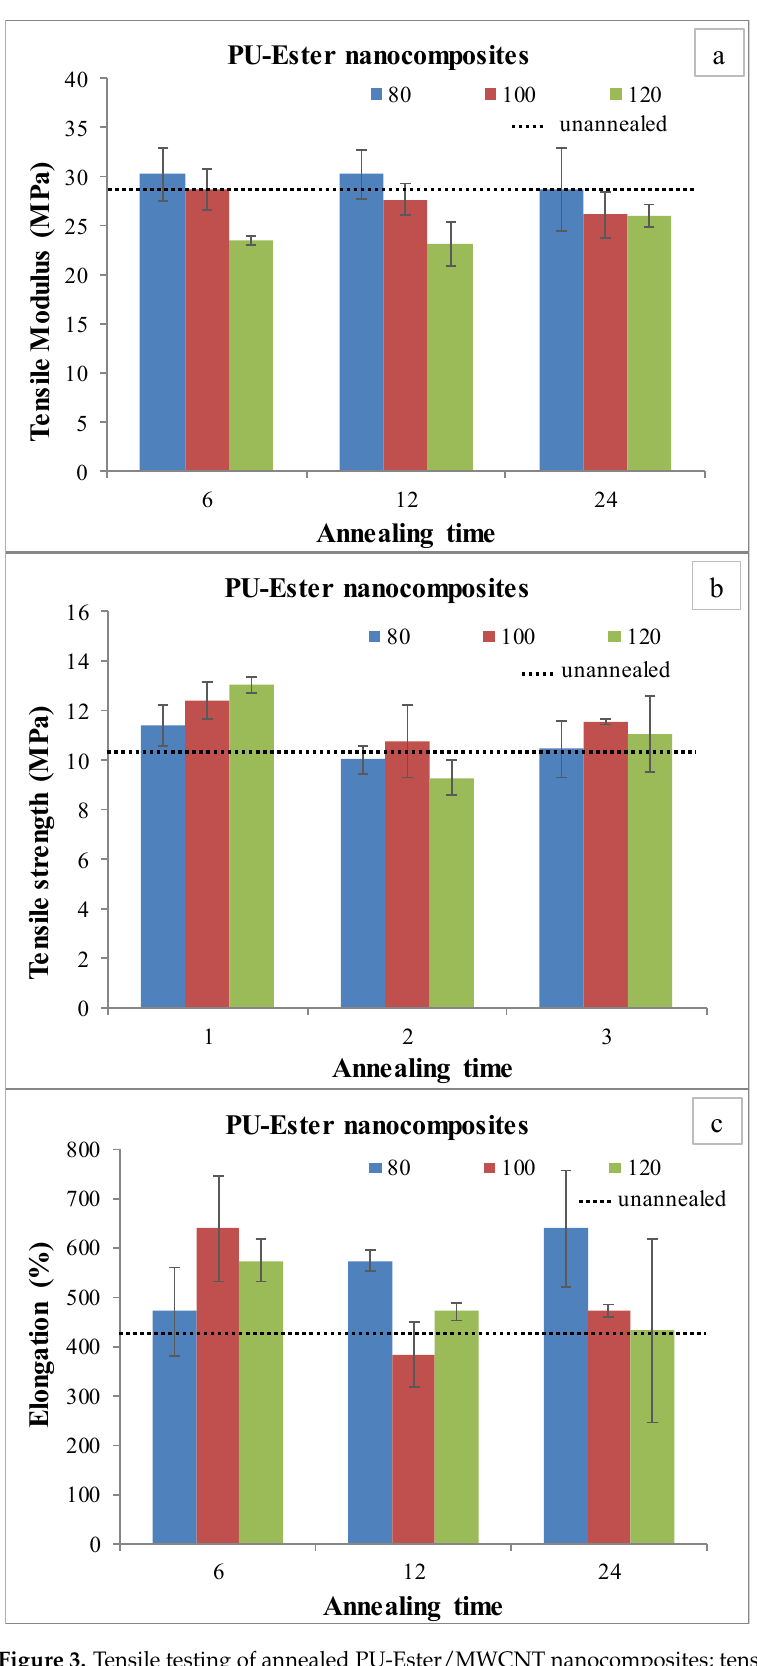
Figure 3. Tensile testing of annealed PU-Ester/MWCNT nanocomposites; tensile modulus ( a ), tensile strength ( b ) and elongation at break ( c